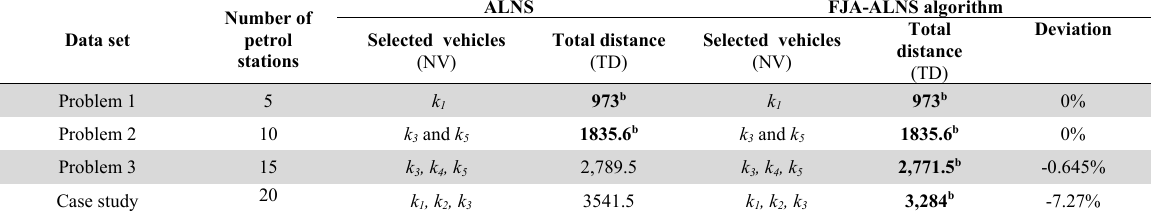
b Best known solution Comparison of solutions using the ALNS and the proposed FJA-ALNS algorithm